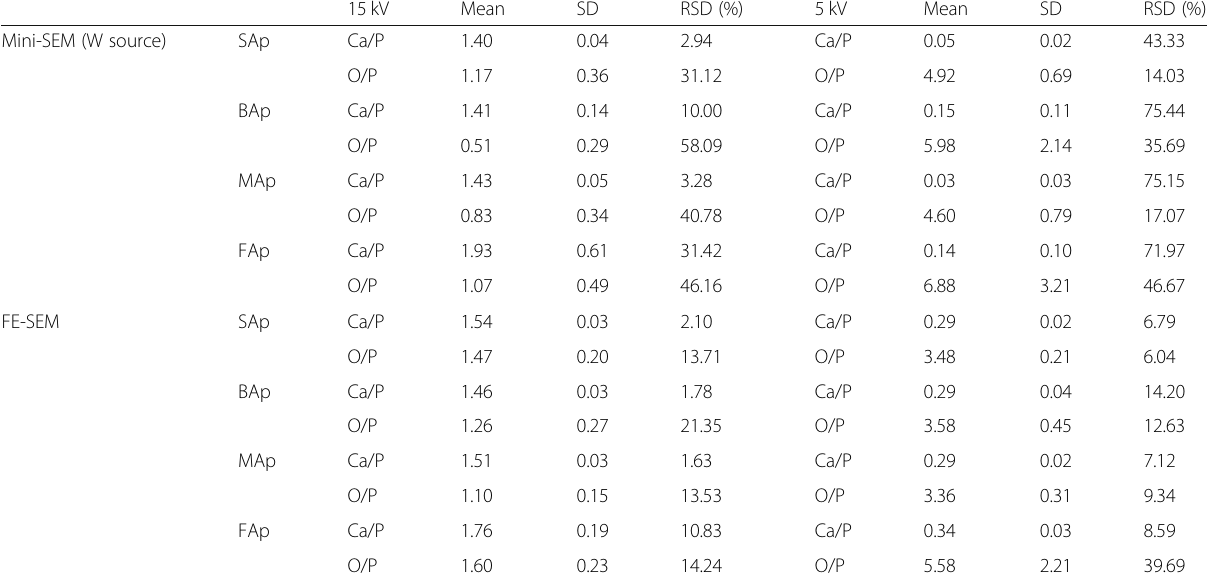
Table 1 Intensity ratios of Ca and O to P at 15 and 5 kV from the Mini-SEM and FE-SEM. (Mean, SD = standard deviation. RSD = relative standard deviation (SD/Mean × 100(%)) 15